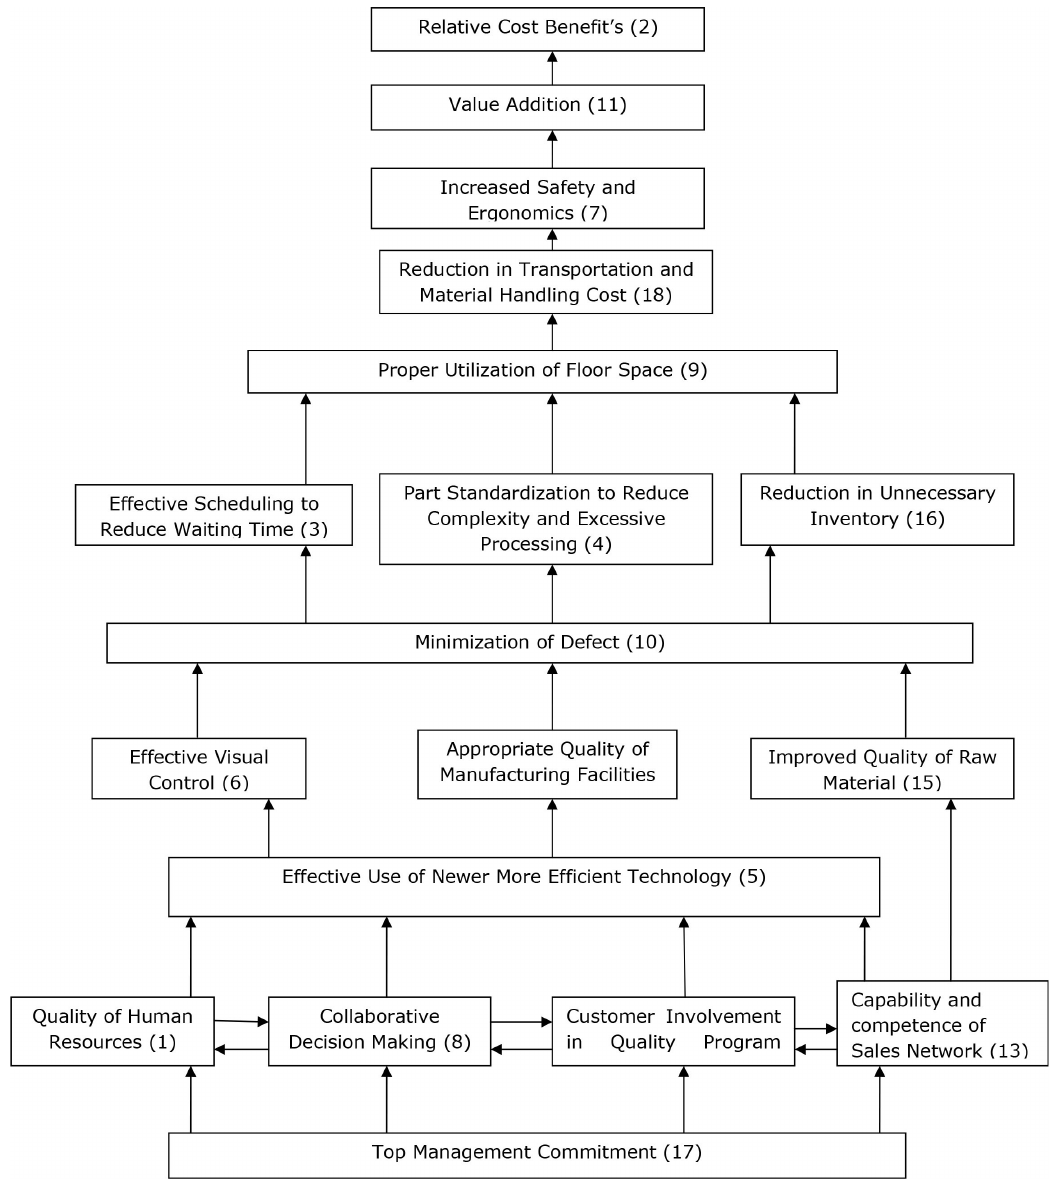
Figure 3. ISM Based Model of Variables of Lean Manufacturing System